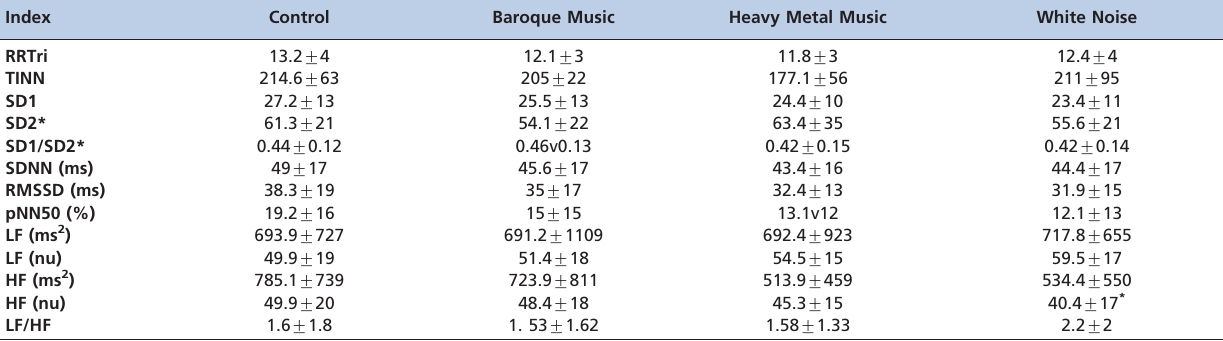
Table 3 - Average values and their standard deviations for the analysis of the time domain, frequency domain and geometric HRV